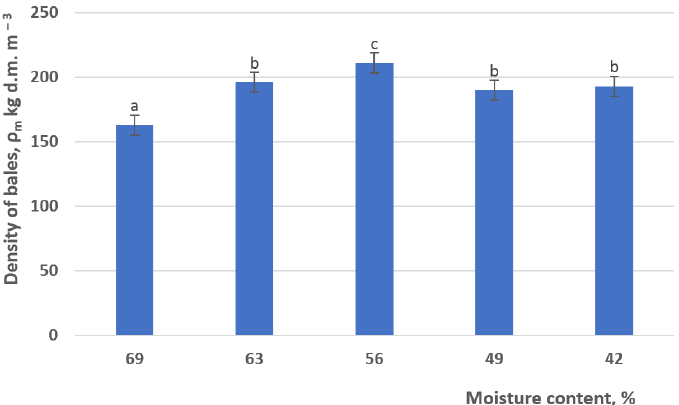
Figure 3. Bar chart of balage density in bales at different moisture content levels at a pressing pressure of 18 MPa and plant material at a length of 312 mm. Different lowercase letters indicate a statistically significant difference at p ≤ 0.05. d.m., dry matter.